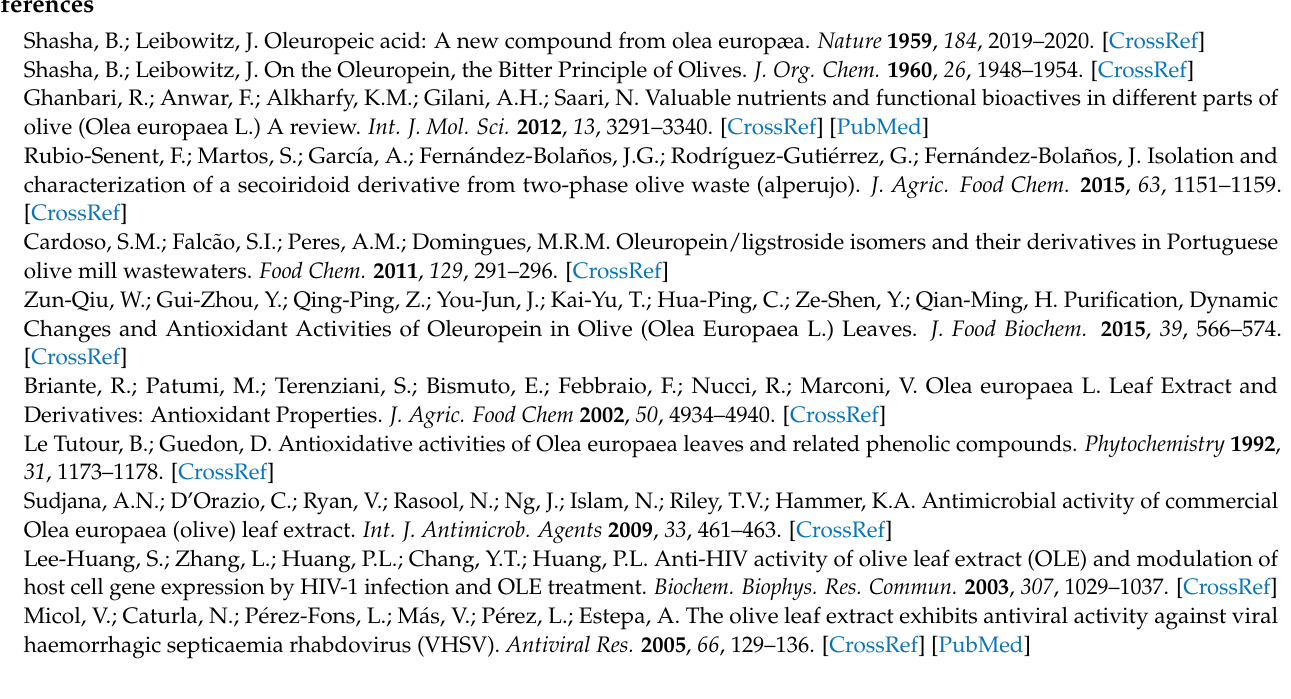
Figure S2: Size distribution for the oleuropein self-assembled structures observed through